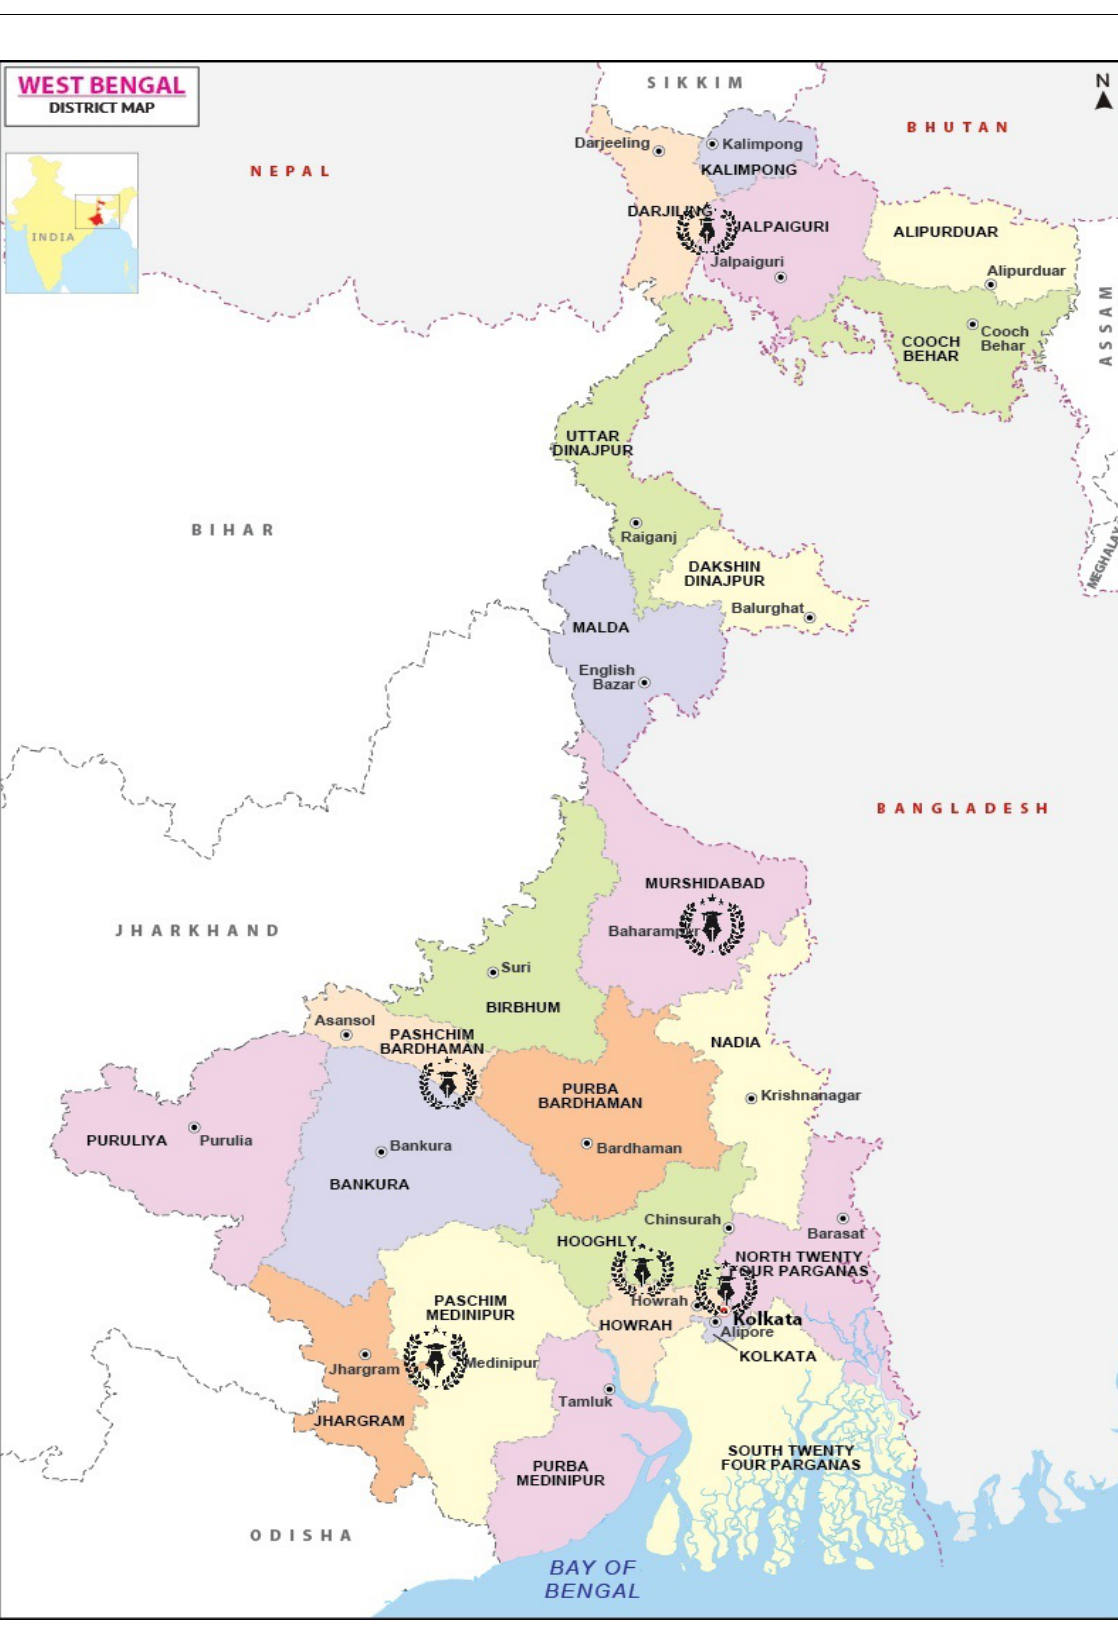
Figure 4. Used locations for Women’s University in West Bengal, India